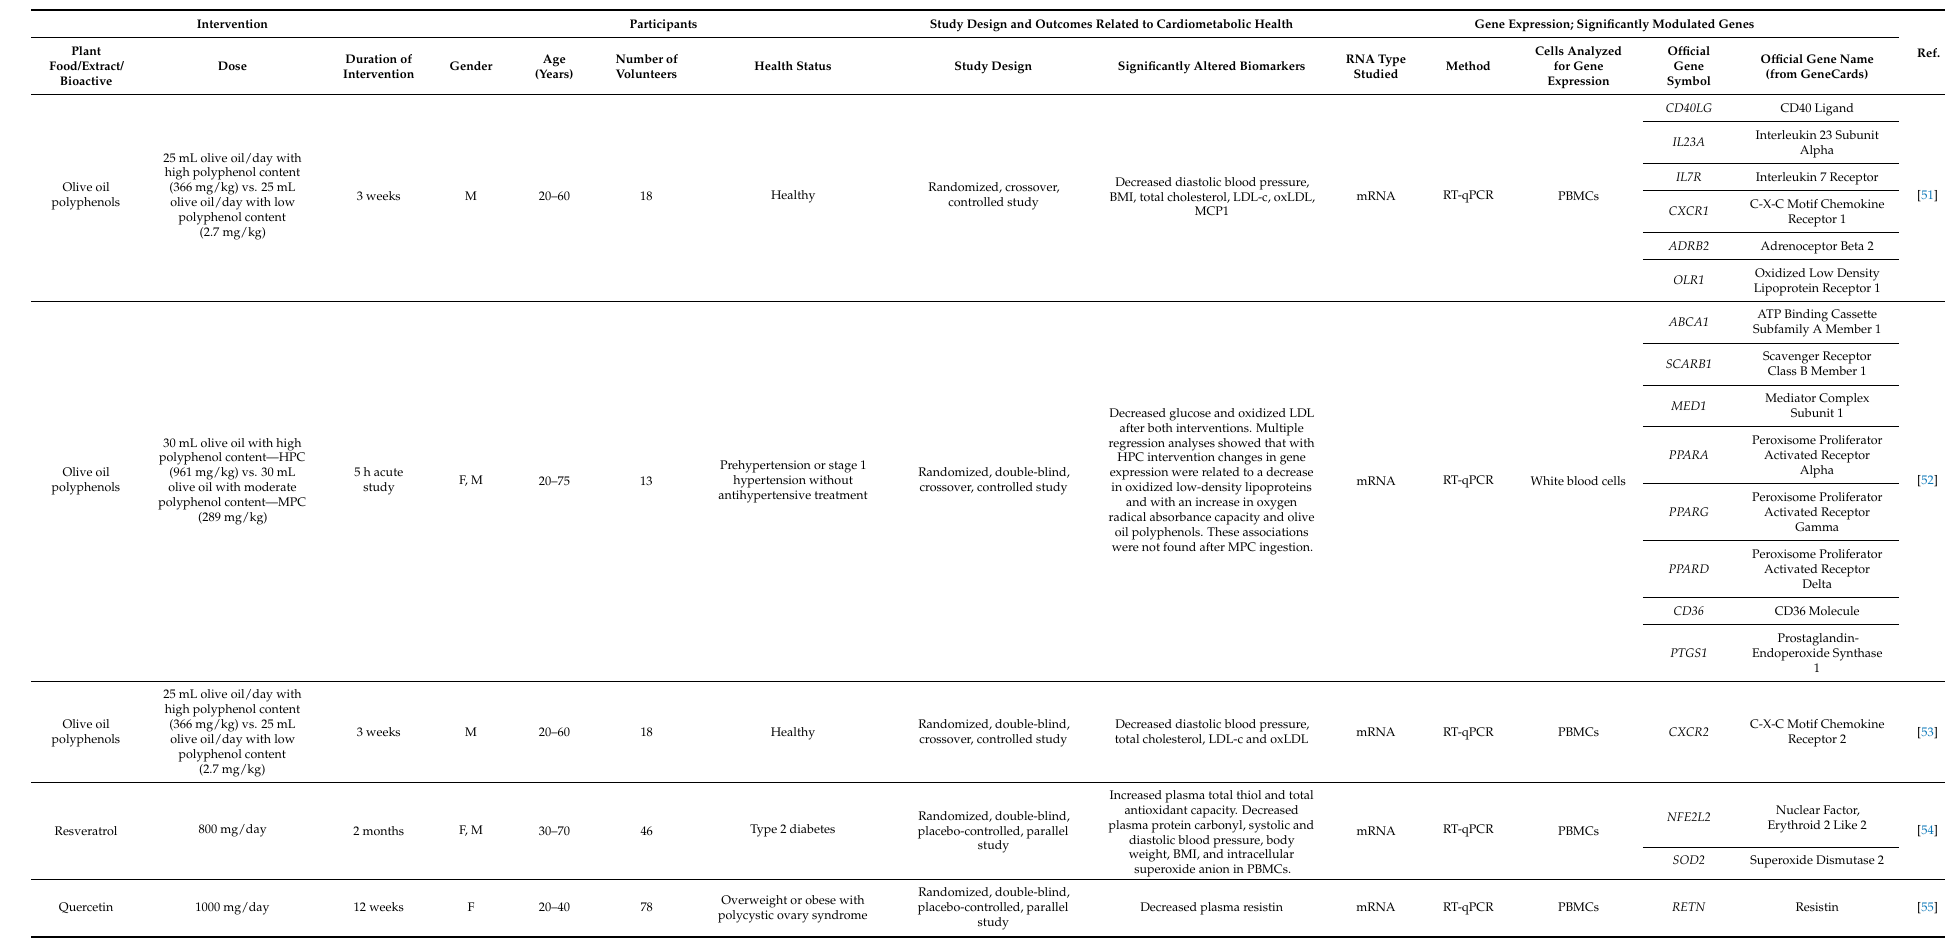
Table 1. Human intervention studies on nutrigenomic effects of polyphenols, associated with positive cardiometabolic